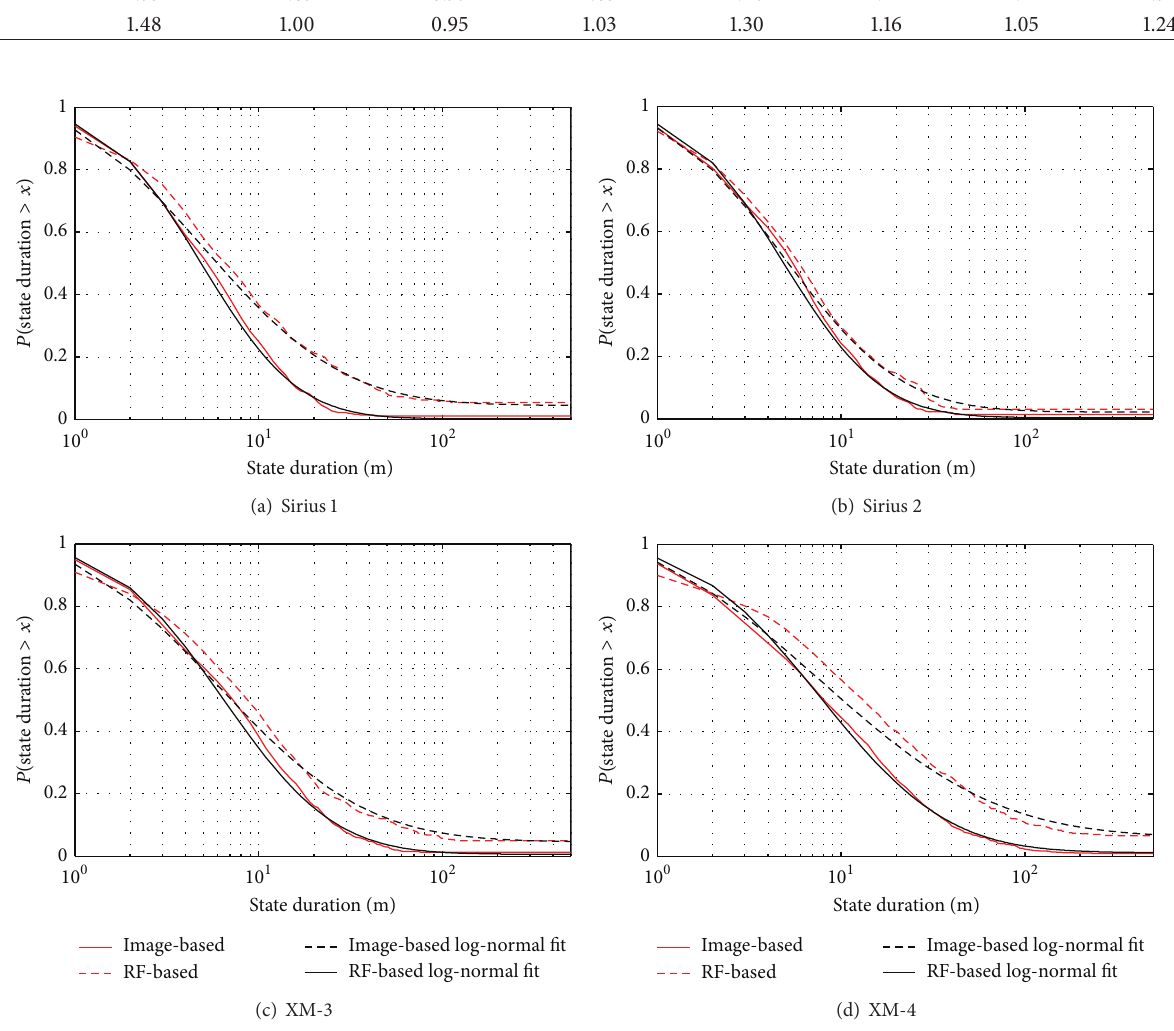
Figure 5: Statistics for bad state for each satellite (Sirius 1, Sirius 2, XM-3, and XM-4) obtained from the image-based state estimation method (red solid lines). As a ground truth, the same plots are shown for the states obtained from the RF measurements (red dashed lines). Furthermore, the log-normal fitting is shown based on images and RF data, respectively (black